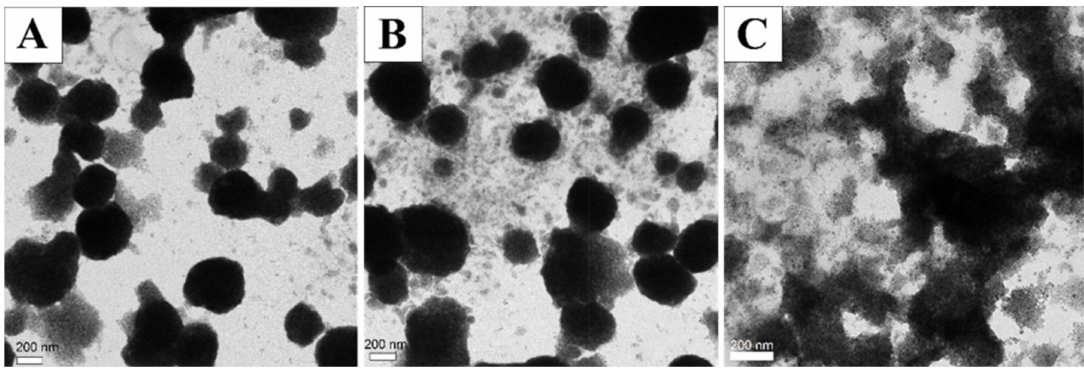
Figure 6. TEM images of ultra-magnetic liposomes (UMLs): ( A ) before and ( B ) after insertion of 10% or ( C ) 40% of 2-(3-[bis(3-aminopropyl)amino]propylamino)- N -ditetradecyl- carbamoylmethylacetamide (DMAPAP). 10% or 40% of DMAPAP per total lipid was added to a diluted dispersion of UMLs (50 mM of Fe, 0.36 µ mol total lipids). After stirring for 1 h, centrifugation, and magnetic separation, TEM images of the post-inserted UMLs was